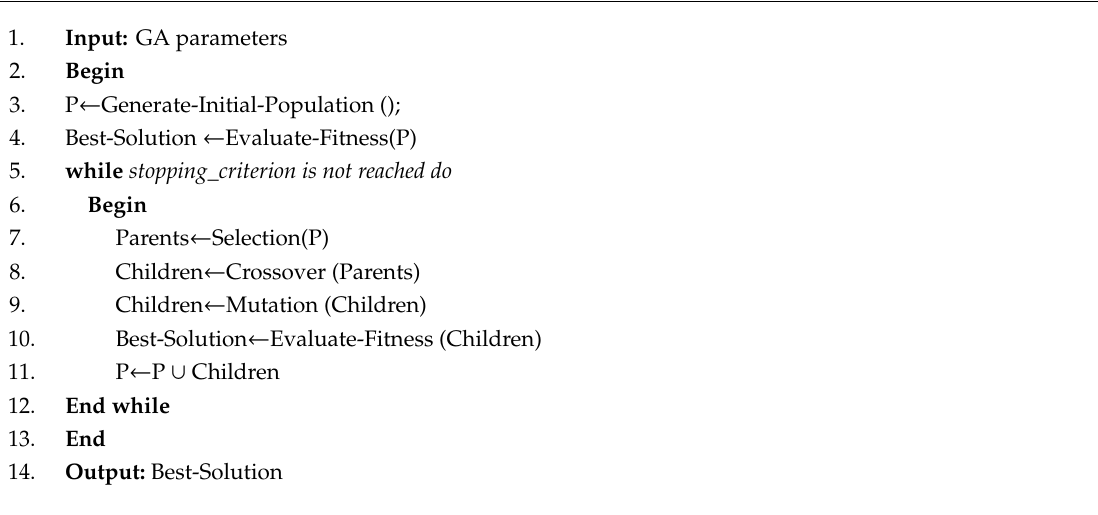
Algorithm 1. The GA pseudocode.